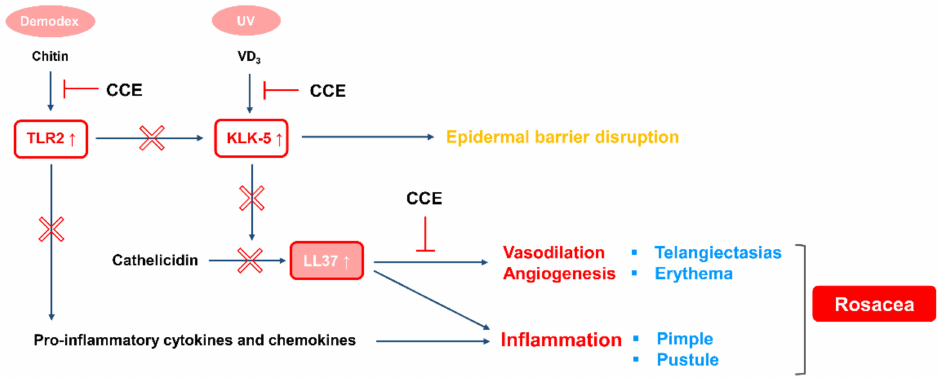
Figure 8. Mechanism of action of CCE in